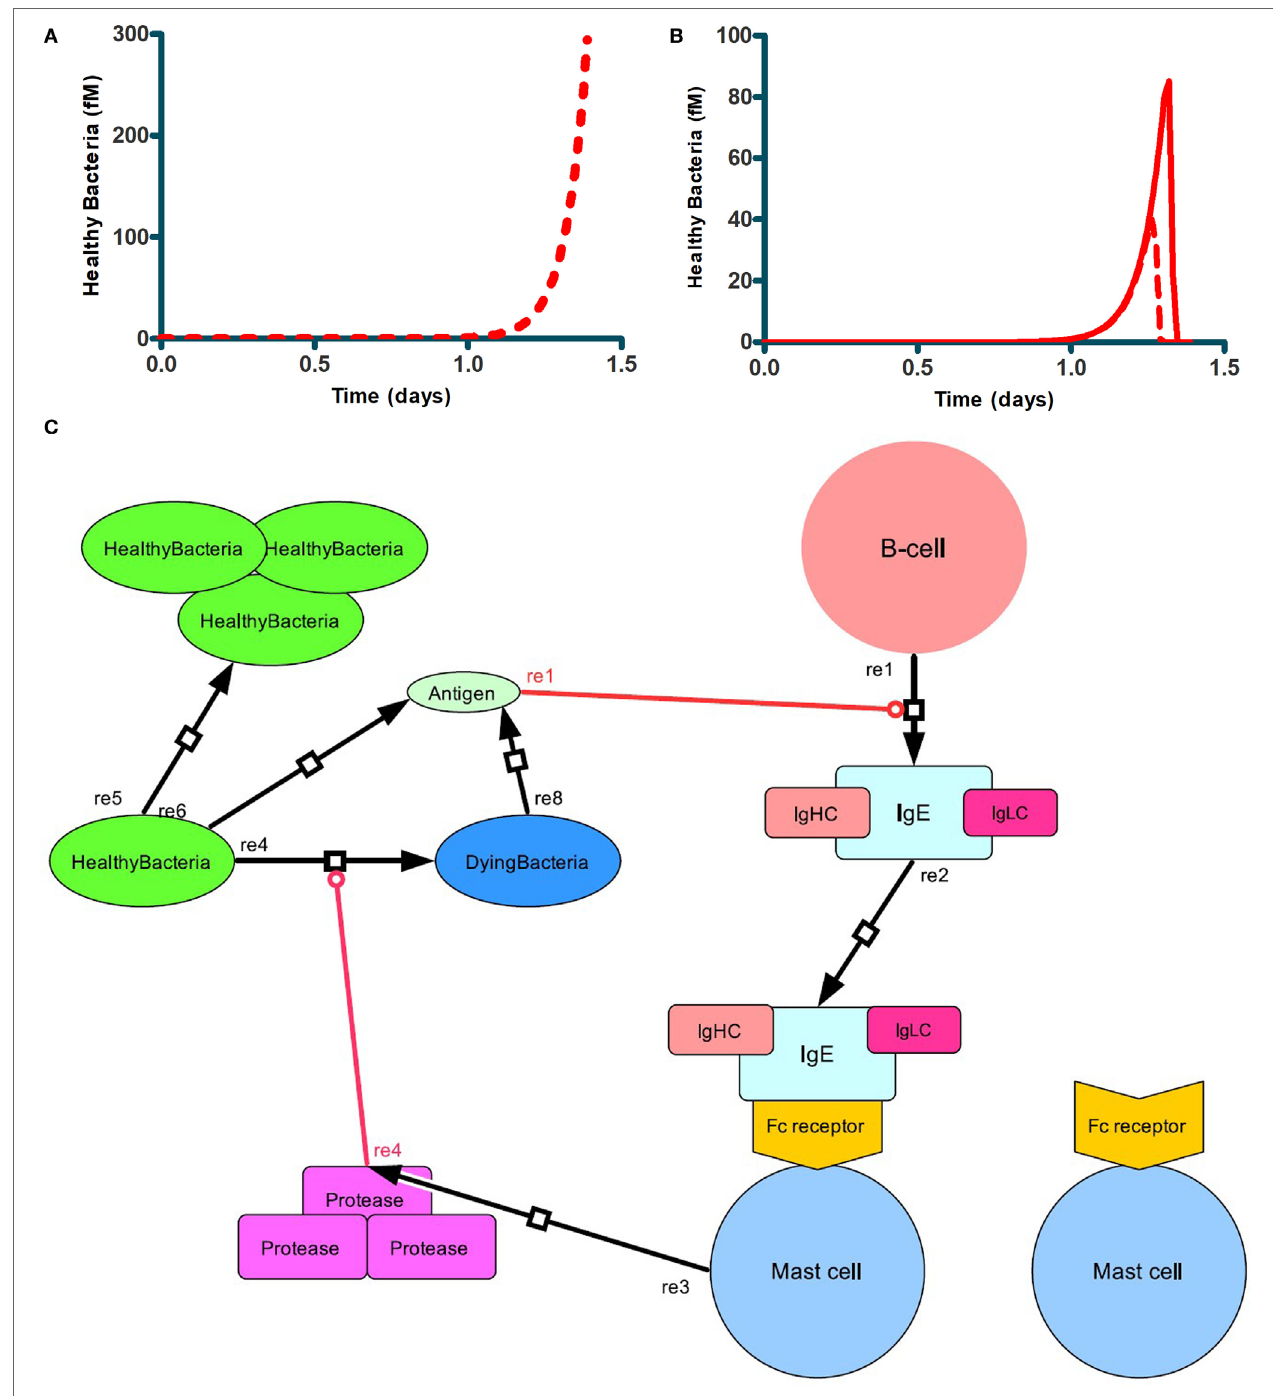
FigUre 2 | Antibacterial function of mast cells producing proteases. Bacterial growth (a) when mast cells produced no protease, i.e., k 25 = 0, or (B) did produce protease at a first order rate constant k 25 = 65/min (full red line), or k 25 = 130/min (dashed red line) (B) . In both cases, bacteria were seeded into the network at t = 0. Mast cell concentration was the standard 0.1 fM. (c) Scheme showing the network response to the bacterial